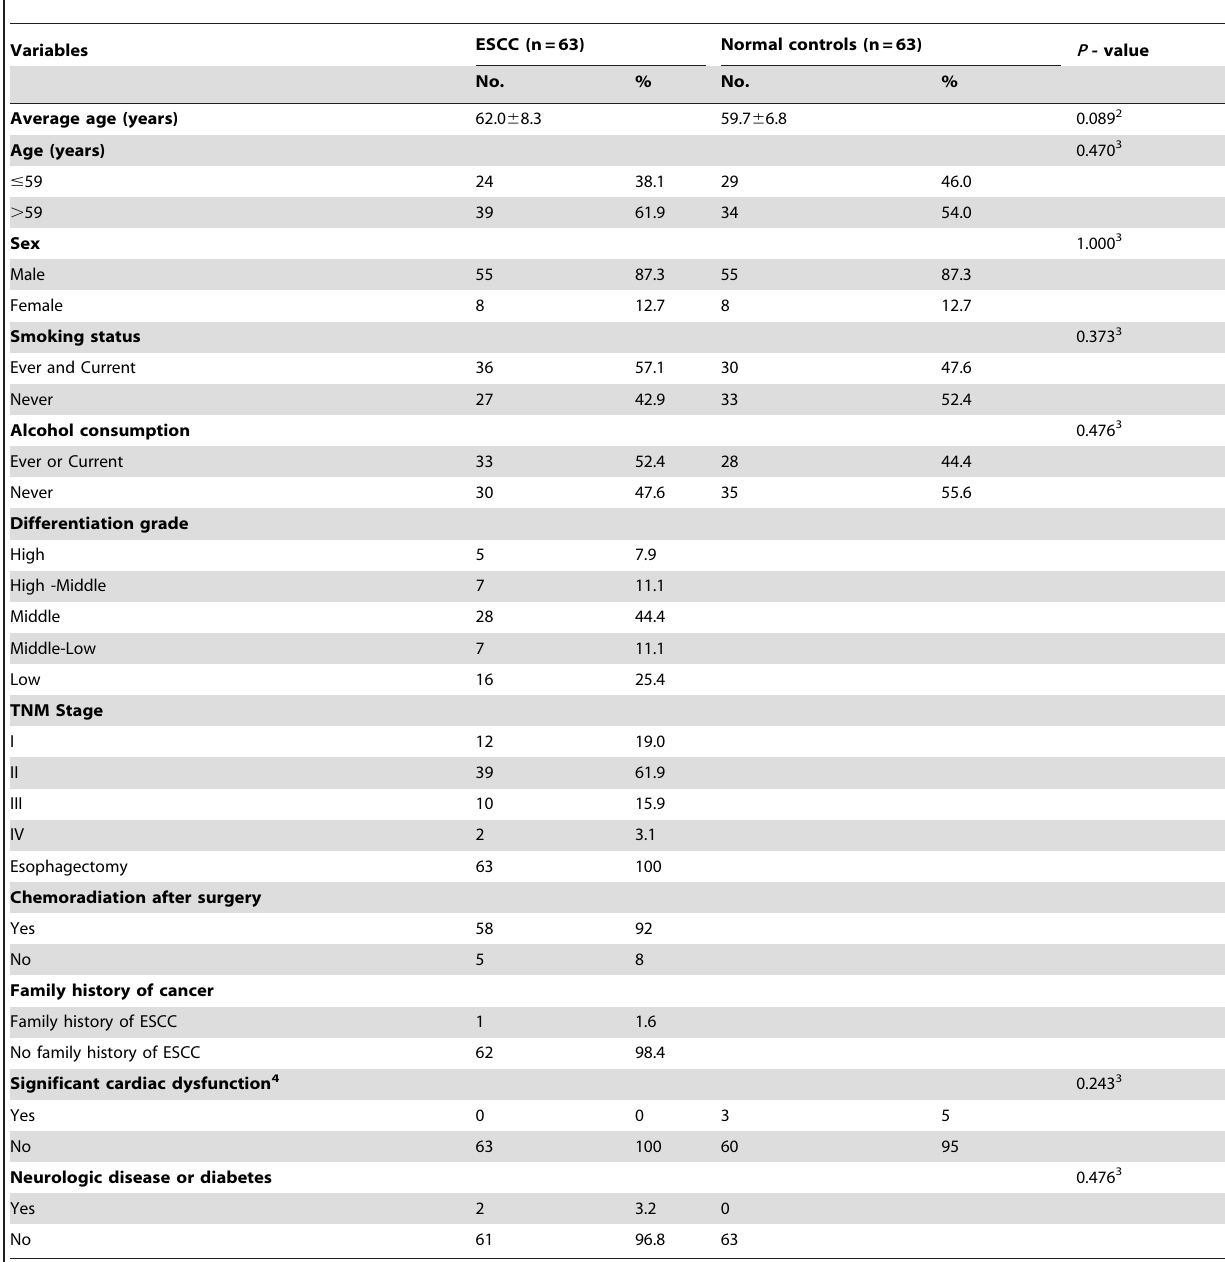
Table 1. Demographic and clinical features of the oesophageal squamous cell carcinoma (ESCC) patients and normal controls whose sera were examined with individual RT-qPCR assays in the validation cohort.